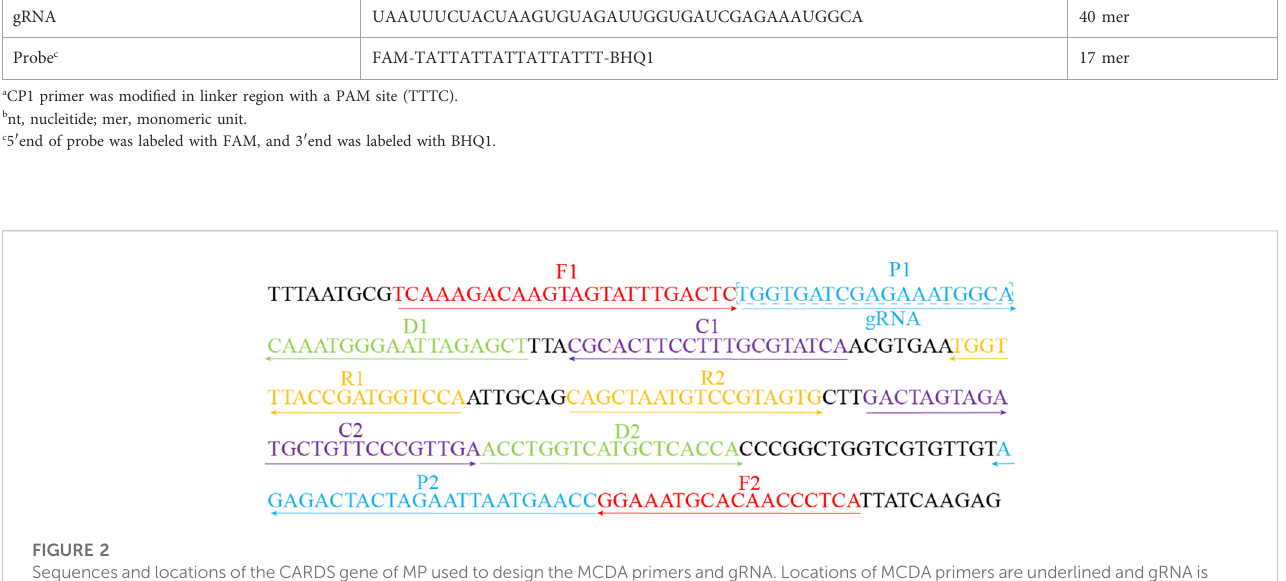
Sequencesand locations oftheCARDSgene ofMPusedto designtheMCDA primersand gRNA. Locations ofMCDA primers areunderlined andgRNA is in the box. The right arrow and left arrow represent the sense and complementary sequence used in this study,